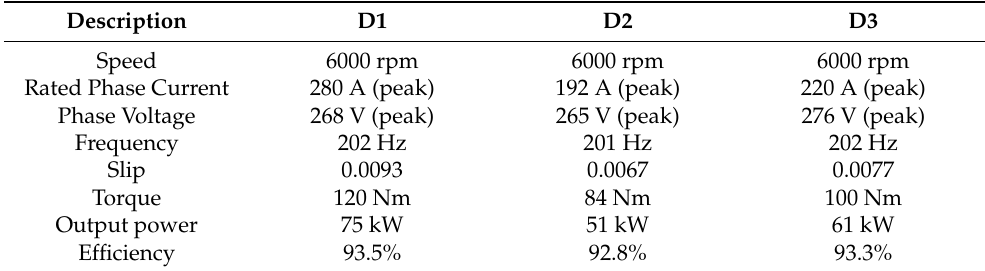
Table 5. Induction motors performances at rated operating